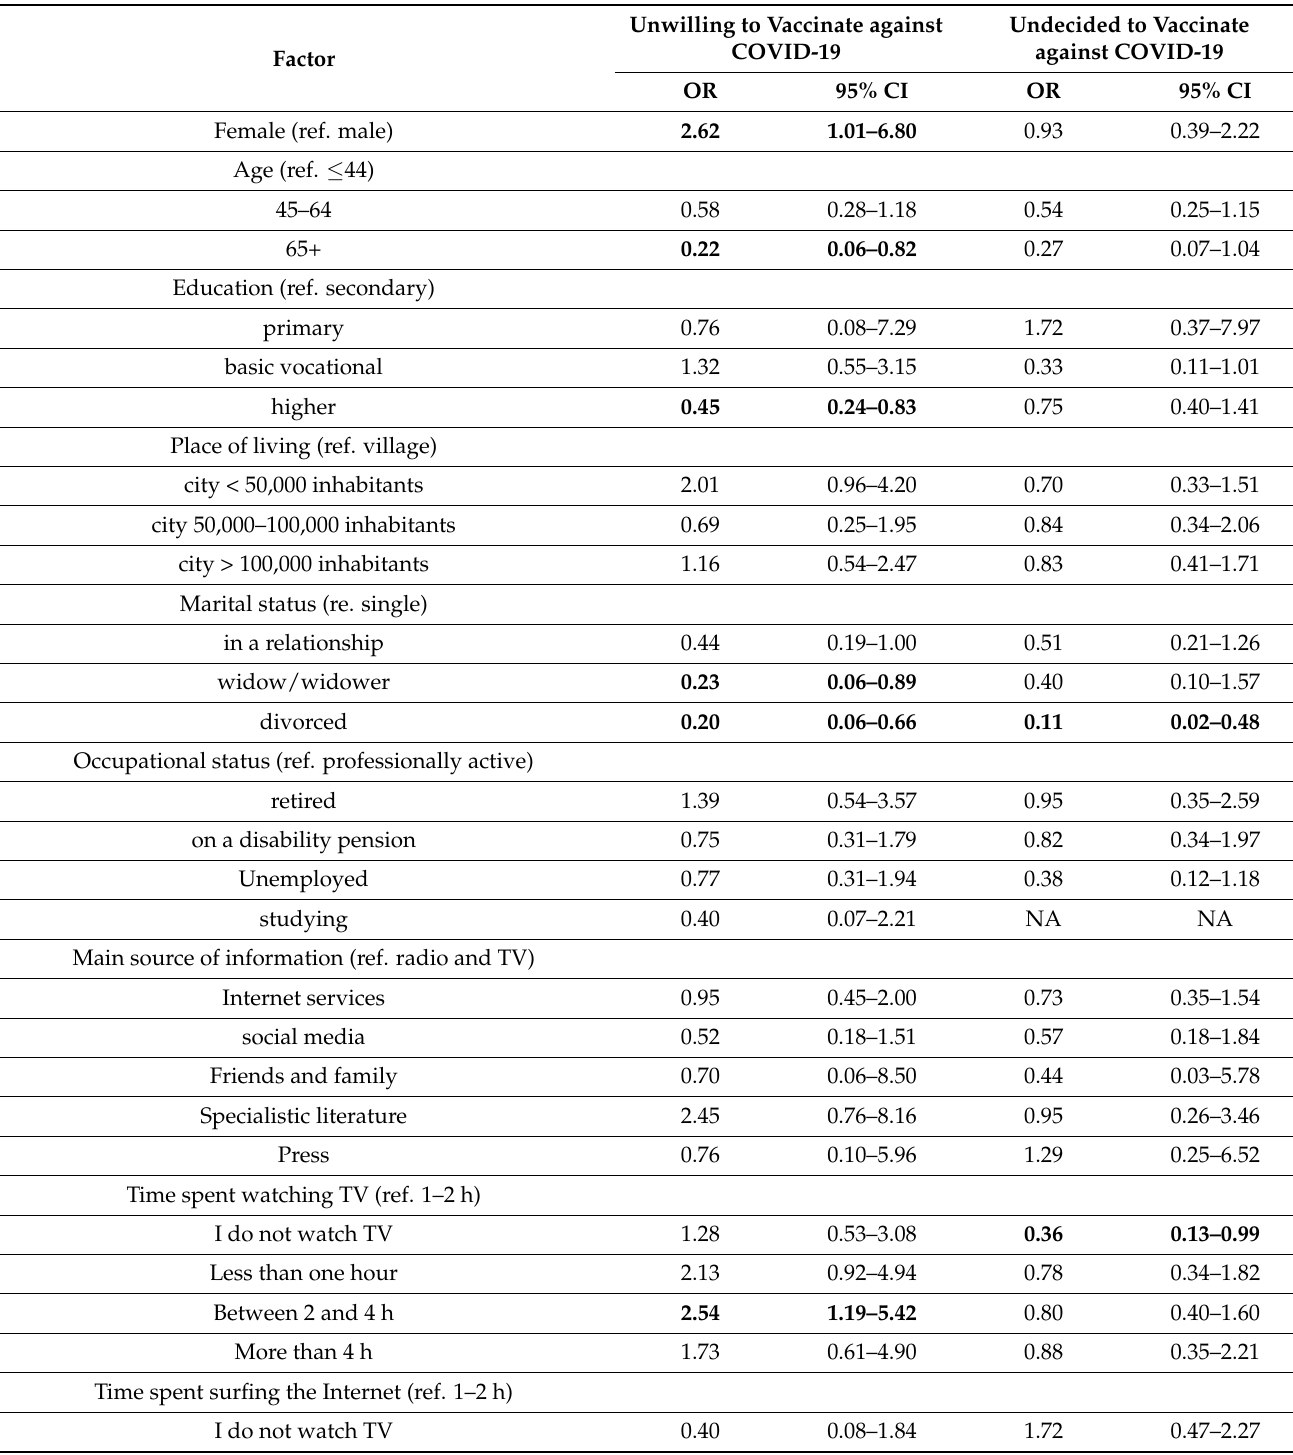
Table 5. Predictors of uncertainty and unwillingness to vaccinate against COVID-19 using multivariable multinominal logistic regression. Significant factors are in